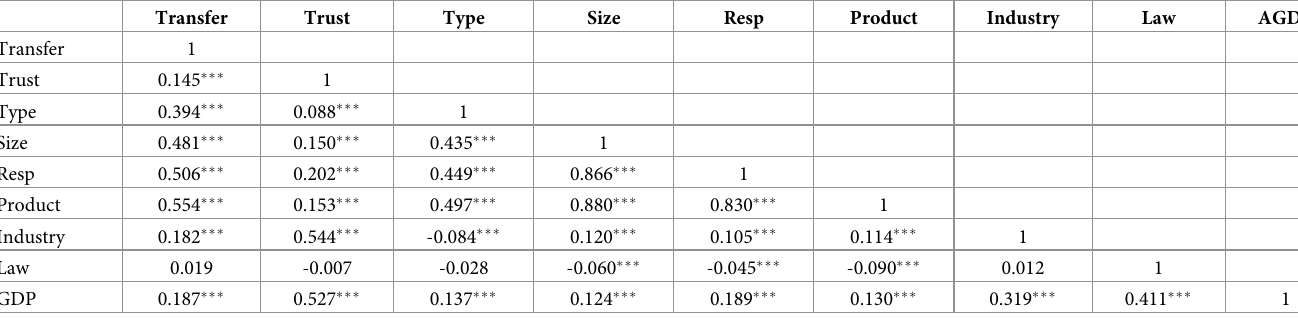
Table 2. Pearson correlation